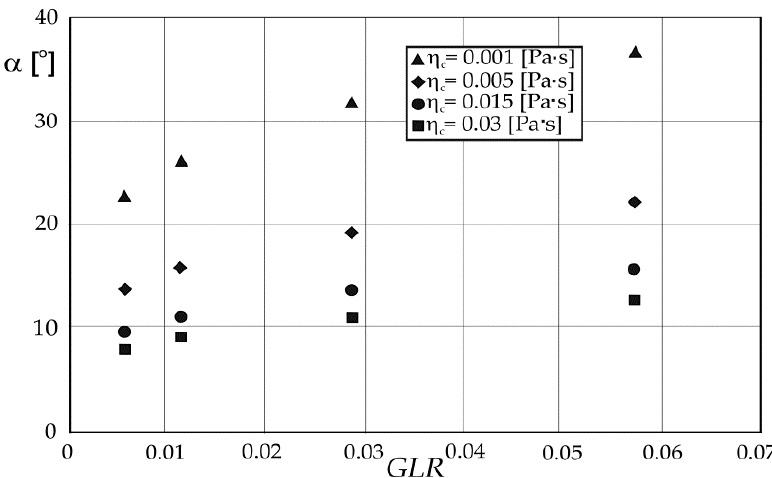
Figure 12. Dependence of the liquid spray angle on GLR for liquids of different viscosity, sprayed with an effervescent-swirl atomizer [7].